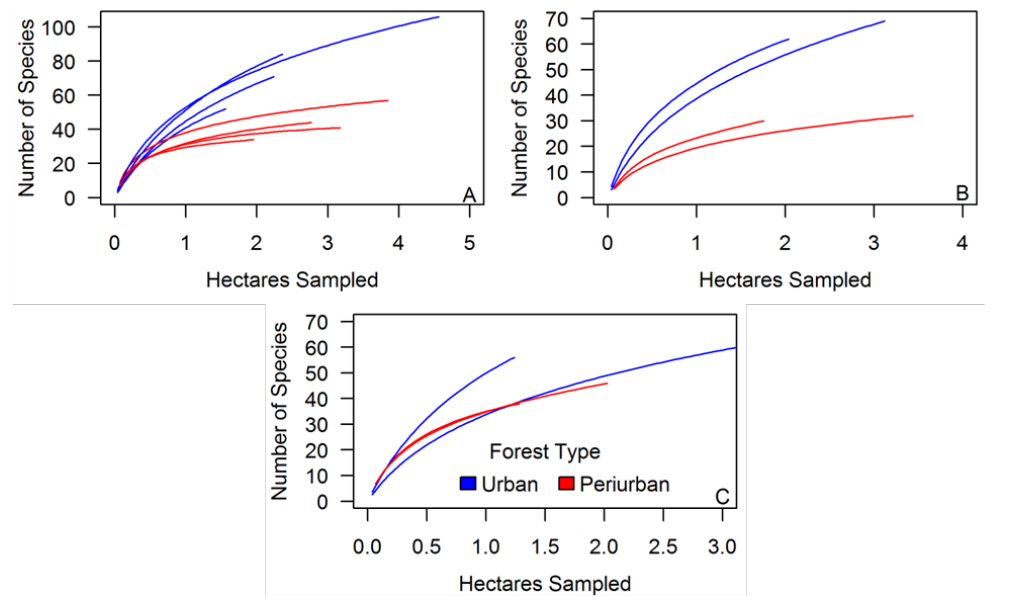
Figure 3. Species accumulation curves by ecoregion in the SE US. Regions are ( A ) Central Appalachian Broadleaf Forest, ( B ) Outer Coastal Plain, and ( C ) Southeastern Mixed Forest (Atlanta urban forest (UF) is truncated in image C for better visualization).